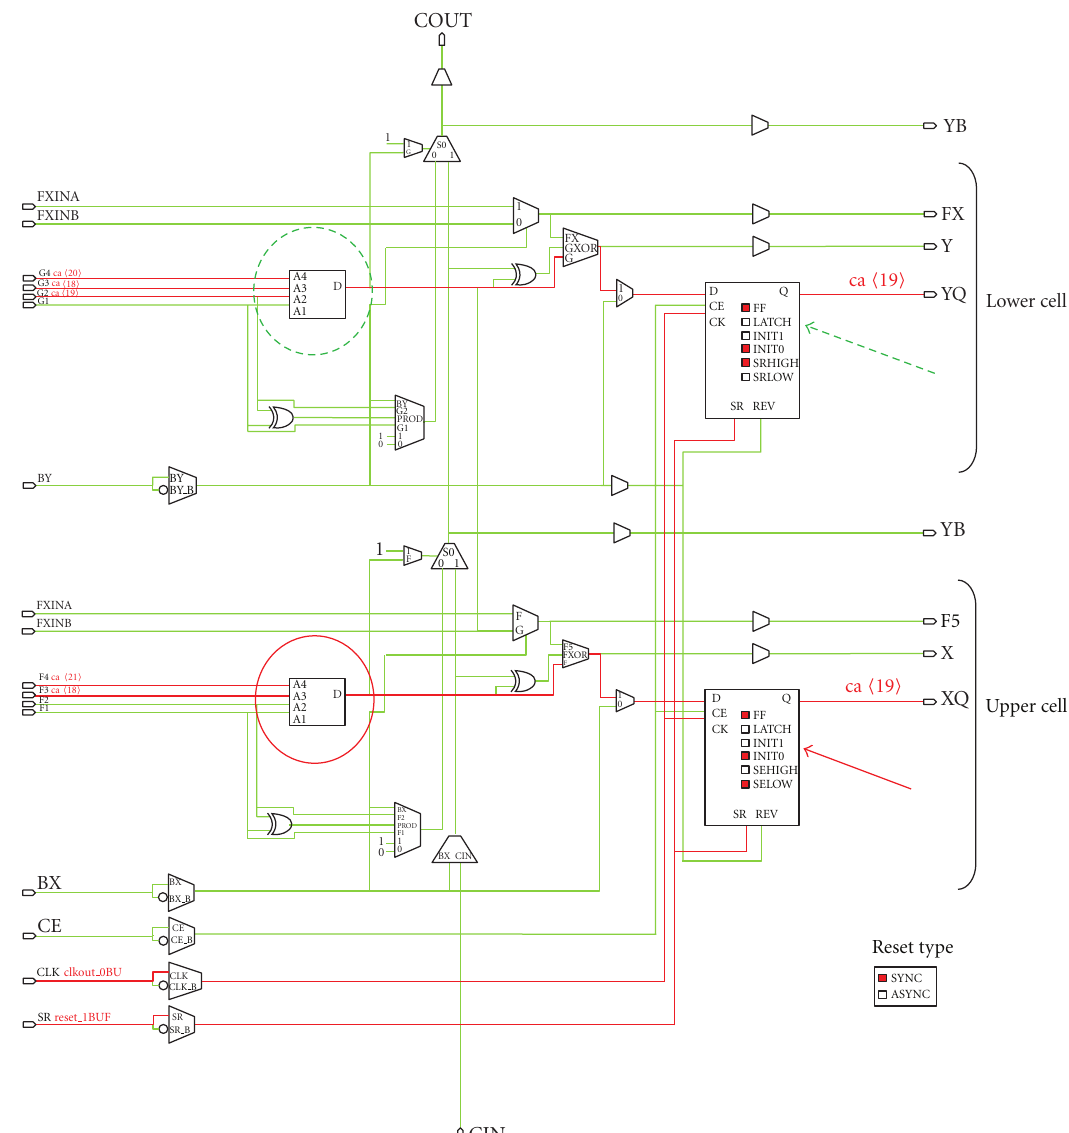
Figure 7: FPGA editor view of the hard macro used to form an SPCA cell showing the lower and upper